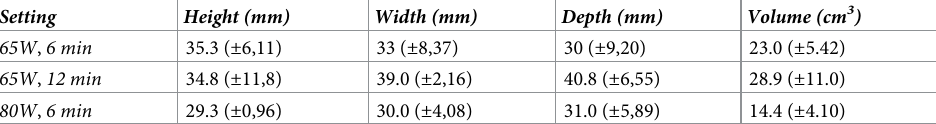
Table 2. Halo size in vivo.